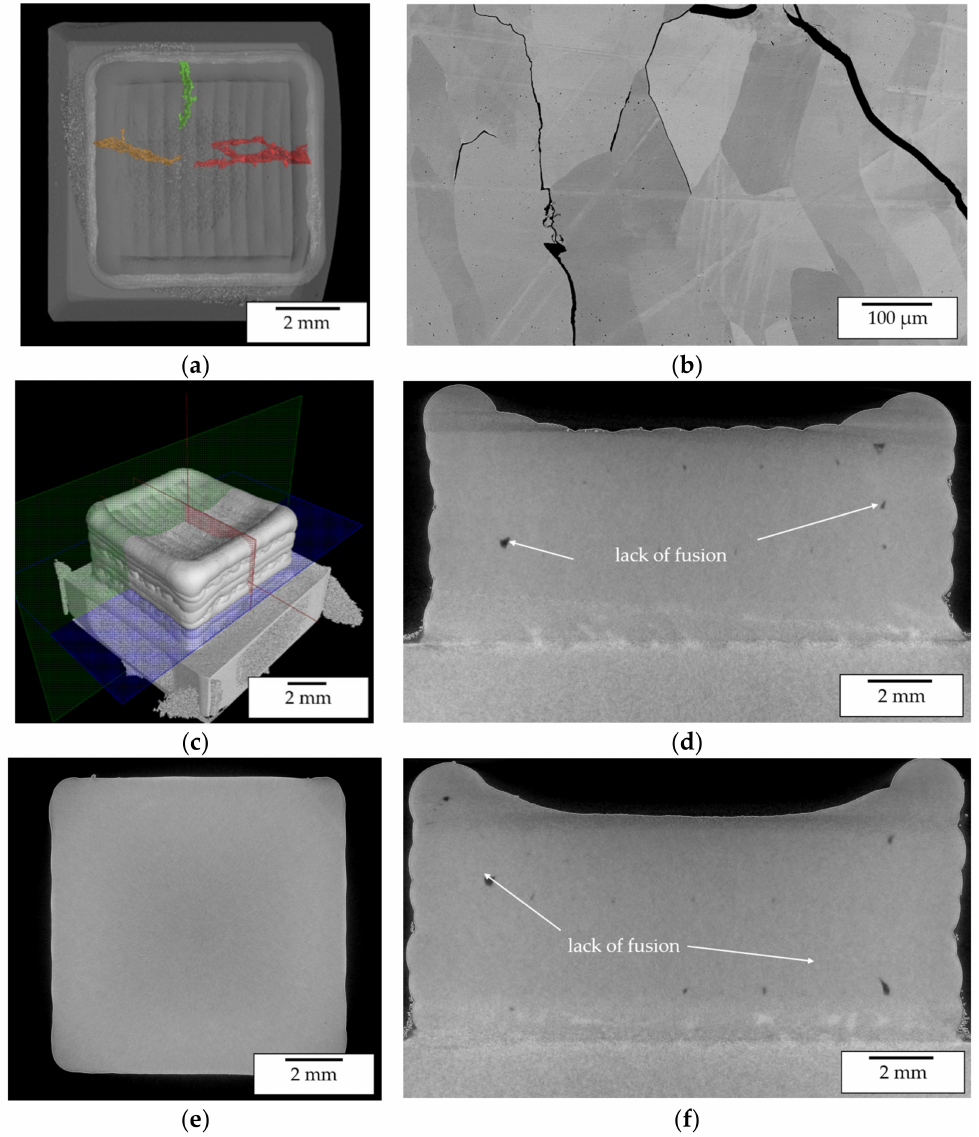
Figure 19. ( a ) CT image exhibiting crack formation perpendicular to the alternating welding direction in a cuboid specimen manufactured at 900 ◦ C preheating temperature using pre-alloyed powder; ( b ) SEM image of crack propagation within cuboid specimen; ( c ) CT iso-view image of cuboid specimen; ( d ) CT image of cross section in zx-plane; ( e ) CT image of cross section in xy-plane; ( f ) CT image of cross section in